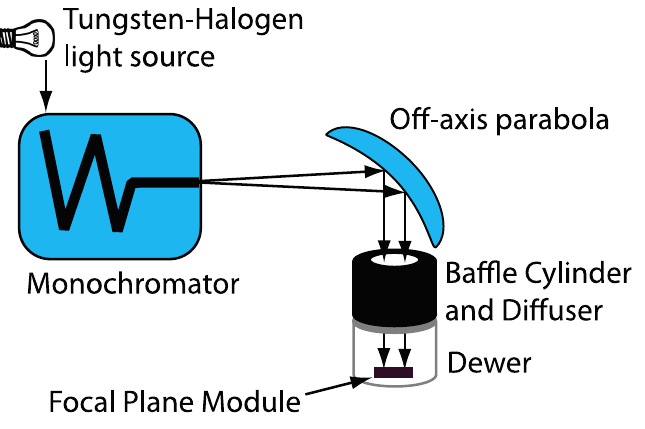
Figure 5. Test setup for FPM-level out-of-band spectral testing. The module is inside an evacuated Dewar. A tungsten halogen lamp illuminates the slit of a monochromator. The monochromatic light is piped through a baffle and diffuser to the